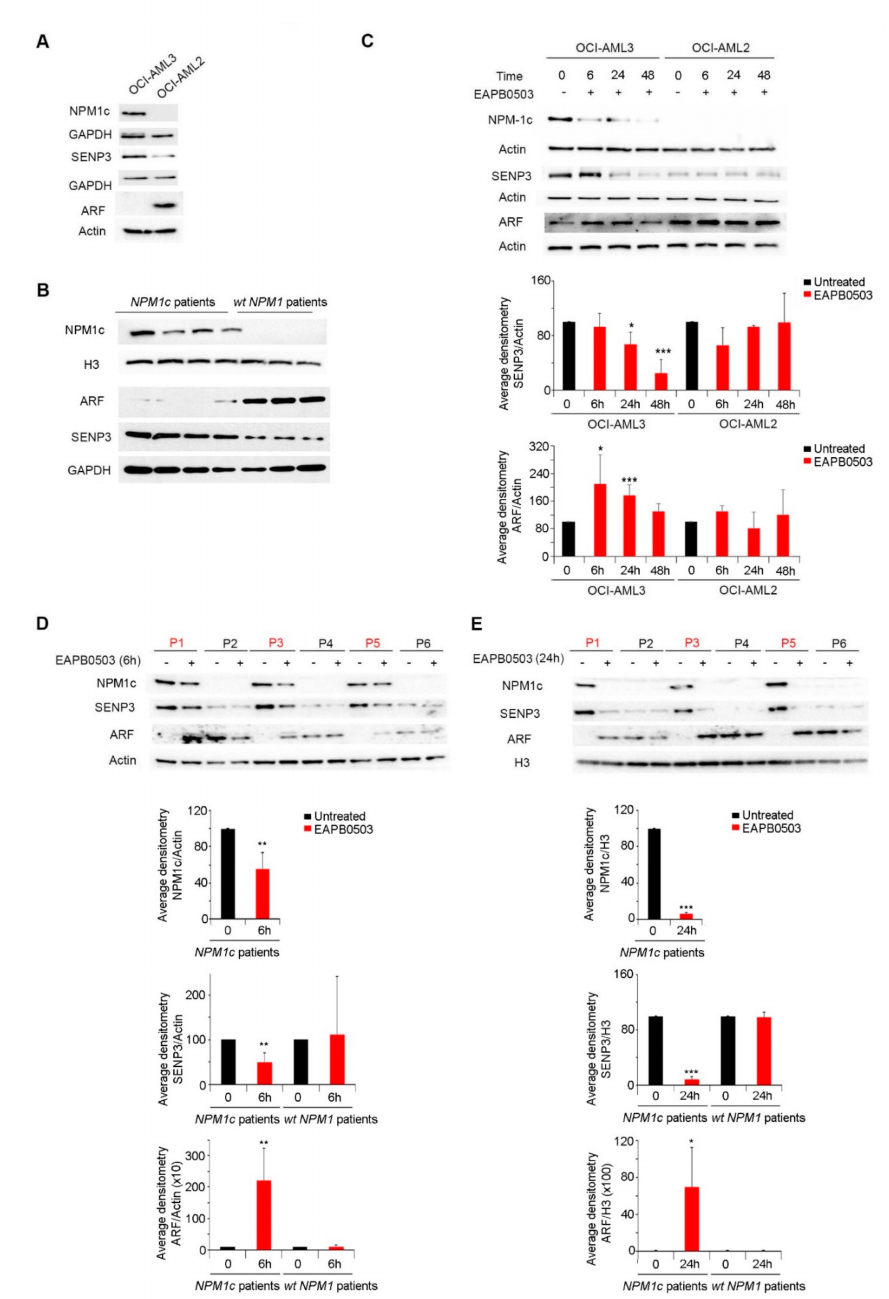
Figure 4. EAPB0503 effect on NPM1c post-translational modification is mediated through the SENP3 degradation and p 14 ARF upregulation. Western blot analysis of basal levels of NPM1c, SENP3,